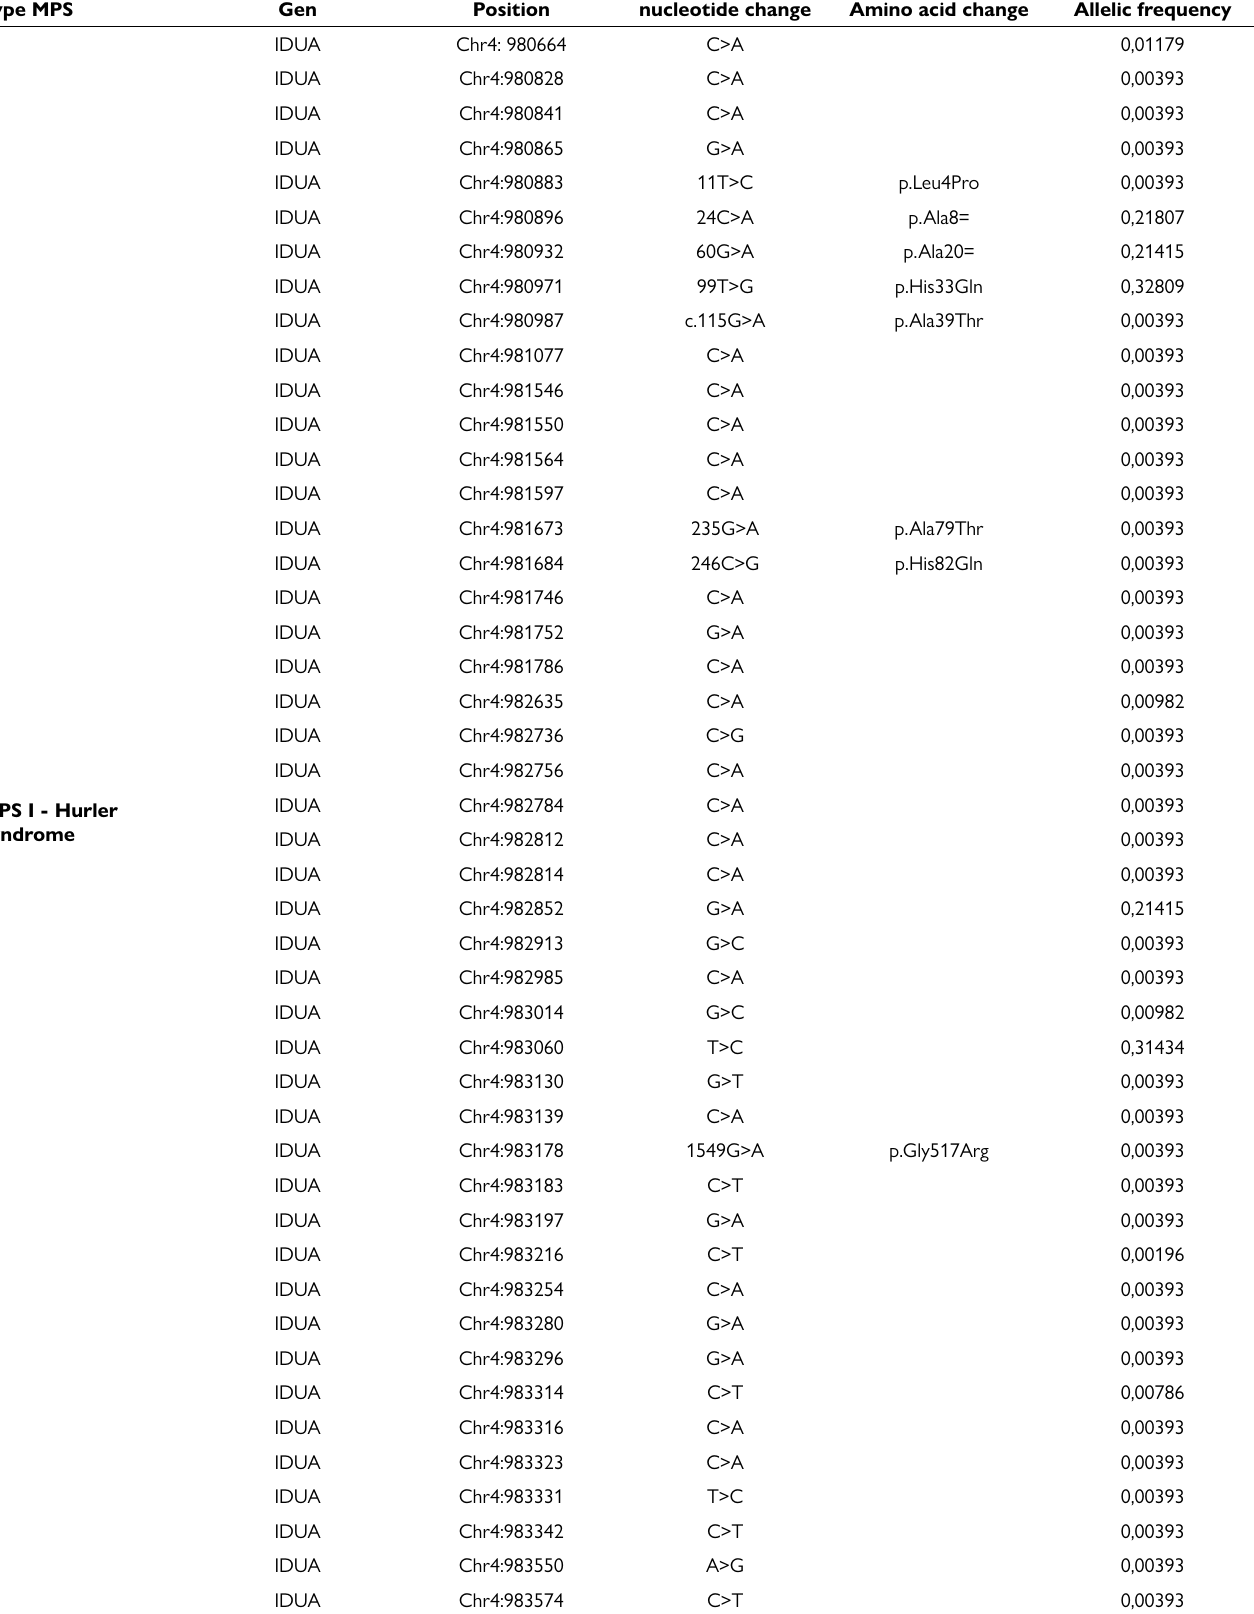
Table 1. Allelic frequency found in gene variants associated with the MPS